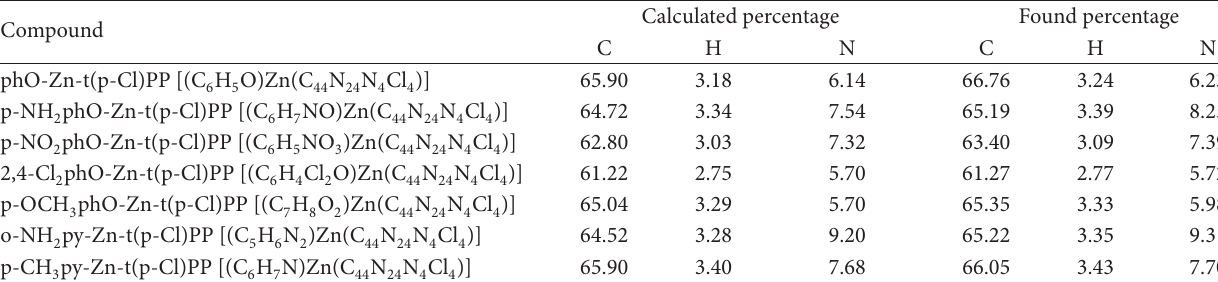
Calculated percentage Found percentage